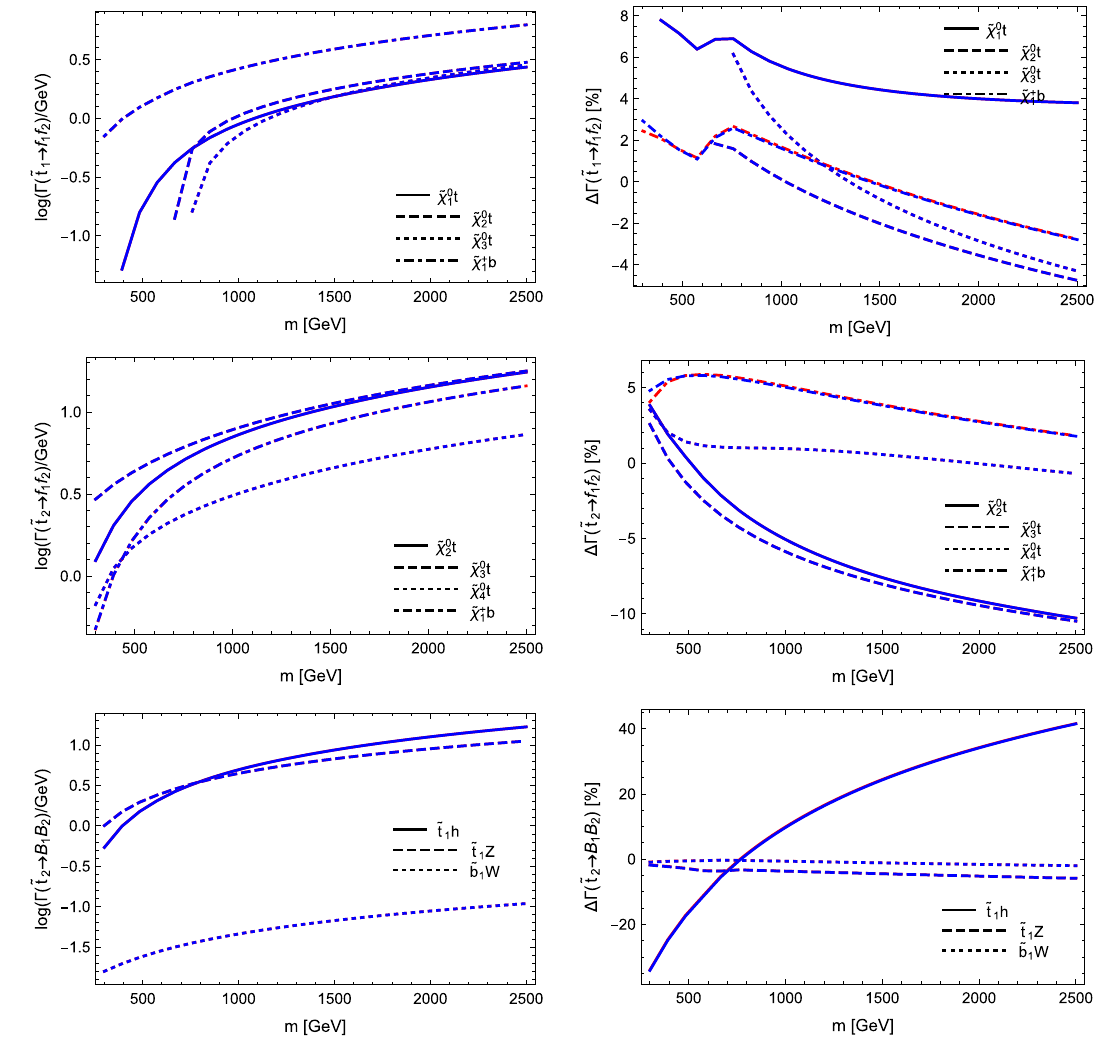
Fig. 4 Comparison between SARAH and SFOLD for selected stop decays. On the left, the loop-corrected partial widths are shown. On the right, the relative size of the loop correction is given. Blue lines are obtained with SARAH , red lines with